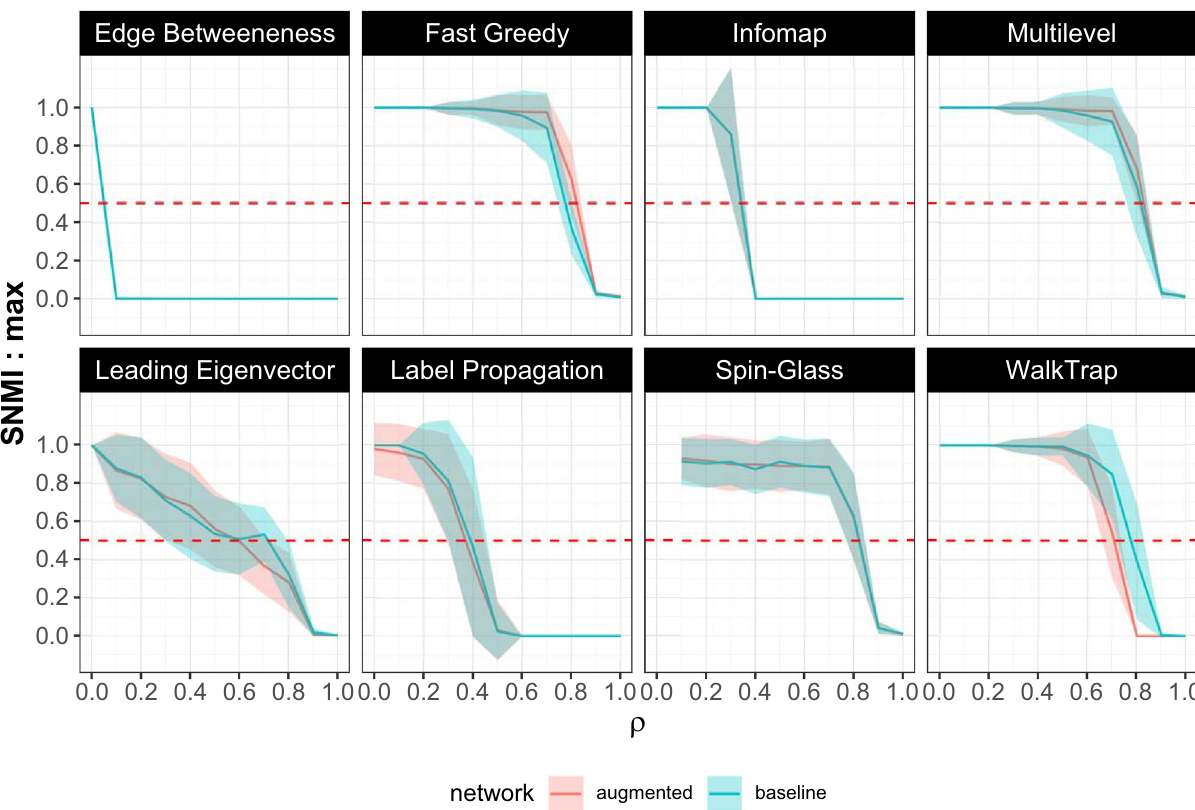
Figure 4. The performances of the 8 community detection algorithms are shown on the “baseline” (cyan) and “augmented” (pink) networks respectively. The y-axis tracks the scaled Normalized Mutual Information (SNMI) value for each algorithm for every value of ρ , that determines the extent of randomness in the agents’ behavior. The solid line tracks the mean SNMI score for the 100 simulations for every value of ρ , while the ribbons indicate the standard deviation around the mean. As ρ increases, SNMI values drop. Fast Greedy, Multilevel, and Spin-Glass outperform the others even when the randomness is substantial. With the augmented networks, While the performances of FG and ML increase, that of WT